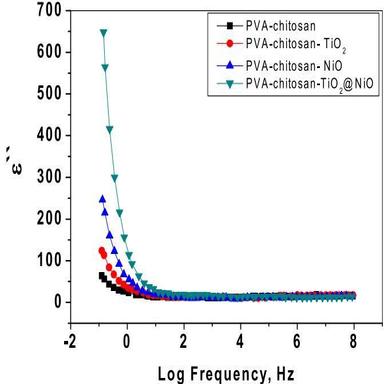
Variation in ε'' with Log f for the PVA-chitosan–TiO2, PVA-chitosan–NiO, and PVA-chitosan– TiO2@ NiO films.